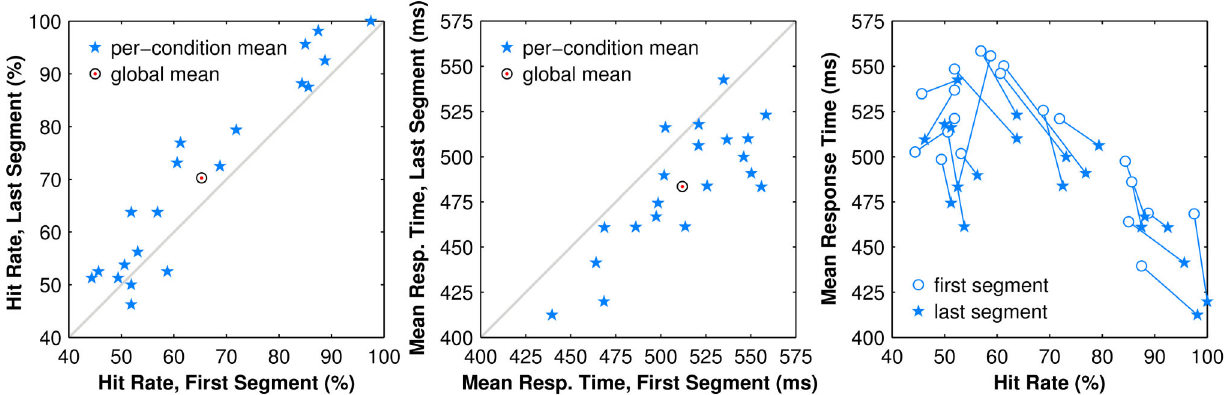
Figure 7. Learning effects. Scatter plots of population hit rate and response time in the first versus last segment of trials. (LEFT) Population hit rates split by condition (stars) and overall mean (bulls eye). Data are above the line of equality as subjects perform more accurately in the last 200 trials (10 per condition) than in the first 200 trials. (CENTER) Population response time for each condition (stars) and overall mean (bulls eye). Nearly every datum is below the line of equality as subjects have faster responses in the last 200 trials than in the first 200. (RIGHT) Combining population response times and hit rates from the two previous graphs with linkages between first (open circles) and last (filled stars) segments reveals two distinct spans of behavior, one at low hit rates that is more disorganized, and one at higher hit rates that displays strong structure. The lower hit rates correspond to the Chance regime where subjects are more likely to be guessing; the higher hit rates correspond to the Mid-Range and High- Performance regimes. The largest improvements, as shown by the longest linkages, cluster around the threshold between Chance and Mid-Range regimes.